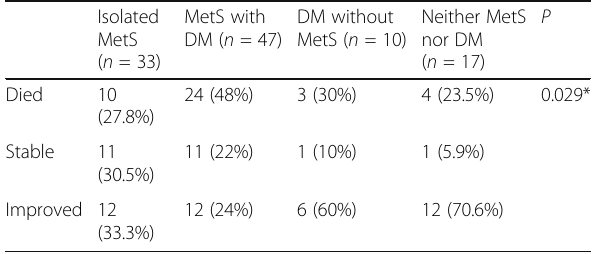
Table 4 Clinical outcome in studied